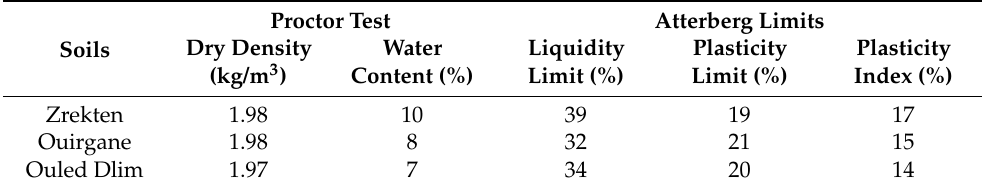
Table 1. Proctor tests and Atterberg limits for the soils.